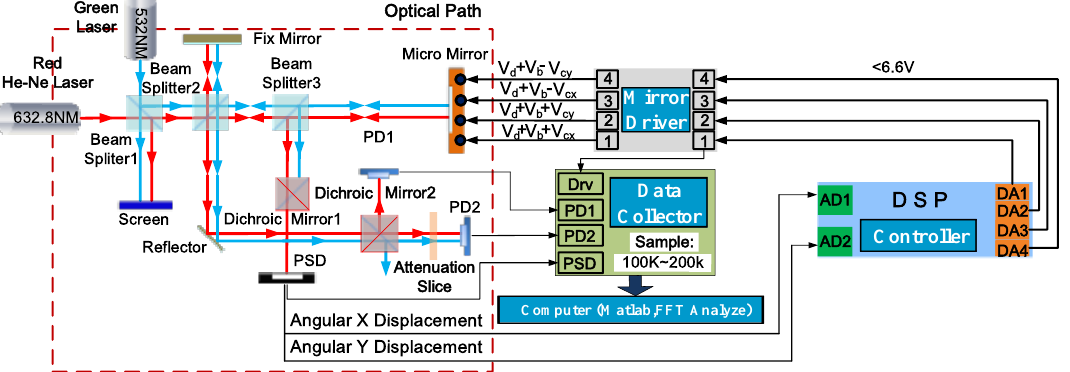
Figure 12. The schematic diagram of the FTS experiment system.